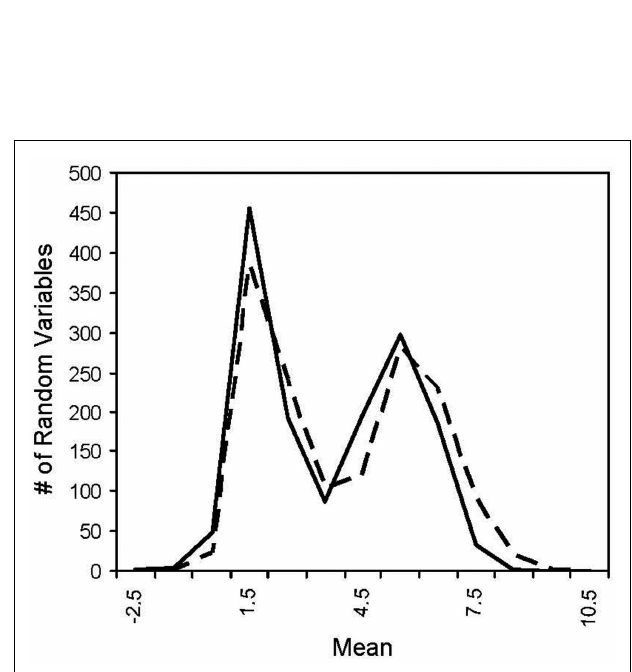
FIGUREA3 | Histogram of two bimodal distributions. The solid line has two modes with a mean of 1 and a mean of 4 and the dotted line has two modes with a mean of 1.36 and a mean of 4.36 where the difference in the distributions yields ∼ 100% power for